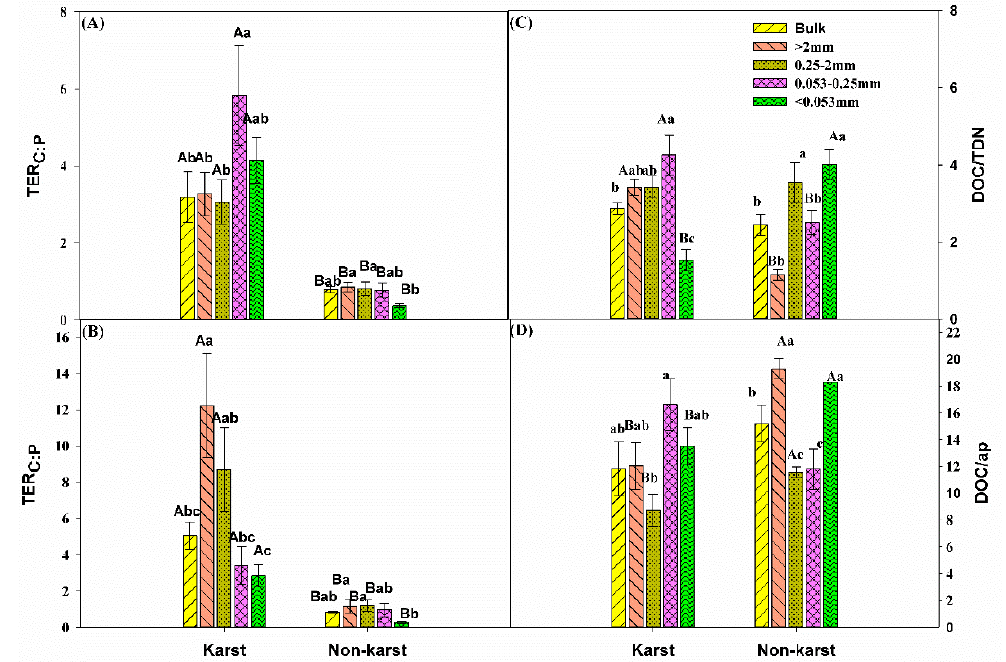
Figure 6. Comparisons of ( A ) the TER of C:N, ( B ) TER of C:P, ( C ) available C:N ratio (i.e., DOC:TDN), and ( D ) available C:P ratio (i.e., DOC:AP) between the karst and non-karst forests. Error bars represent the standard deviation. Capital letters indicate differences among the forest ecosystems in the same aggregate size. Lowercase letters indicate differences in aggregate size fractions in the same forest ecosystem. TER, Threshold Elemental Ratios; DOC, dissolved organic C; AP, acid phosphatase.